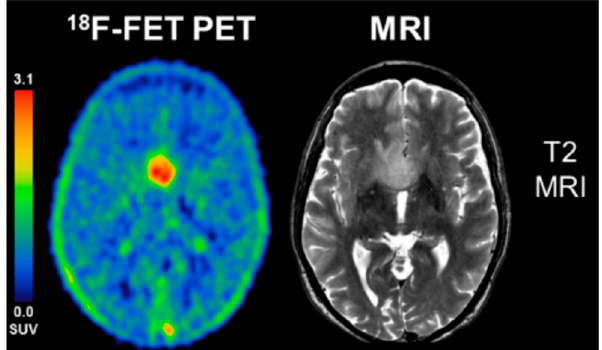
Figure 2. 18 F-FET PET summation image from 5–15 min is contrasted to a T2 MR image in this patient with a WHO III astrocytoma, IDH-wild-type, without 1p/19q co-deletion. This was a non-enhancing tumor on MRI. Note excellent tumor to background contrast for the FET PET image, with standard uptake values (SUV) of up to 3. Adapted from Unterrainer et al. Eur. J. Nucl. Med. Mol. Imaging 2018, 45, 1242 with permission [51].